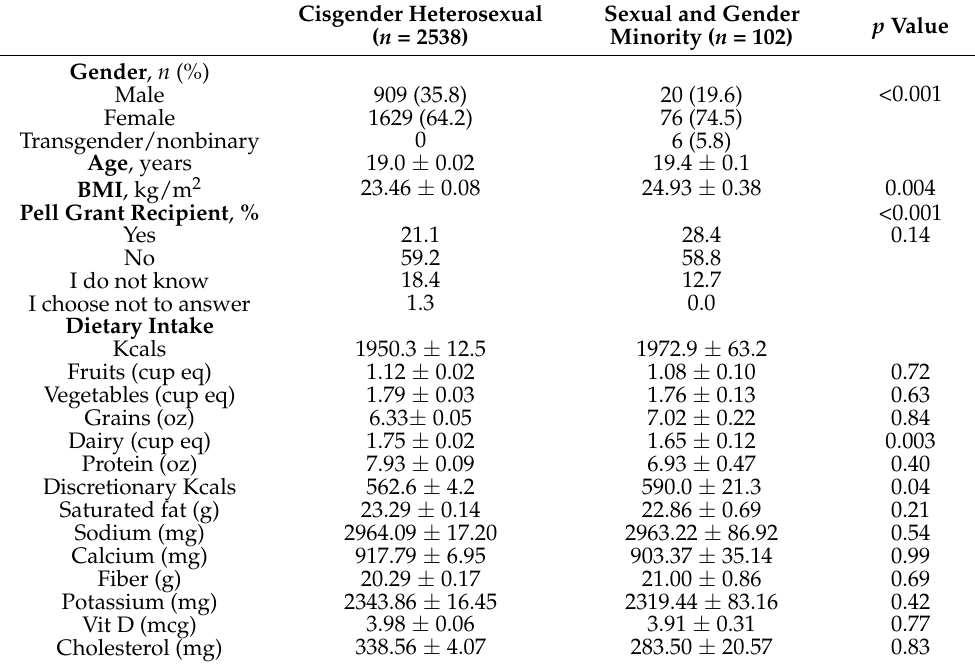
Table 1. Characteristics by sexual orientation and gender identity.